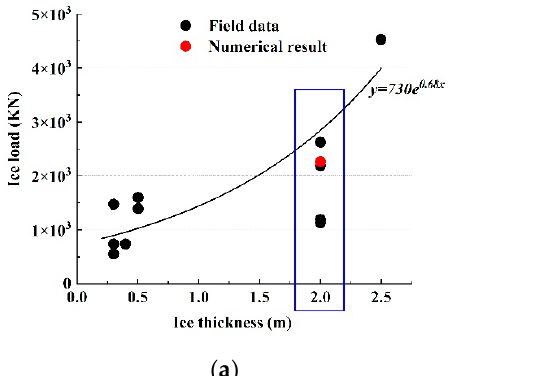
Figure 11. Numerical simulation of ice load on Kulluk platform. ( a ) Level ice condition; ( b ) broken ice floes condition; ( c ) front view under level ice condition; ( d ) front view under broken ice floes condition.